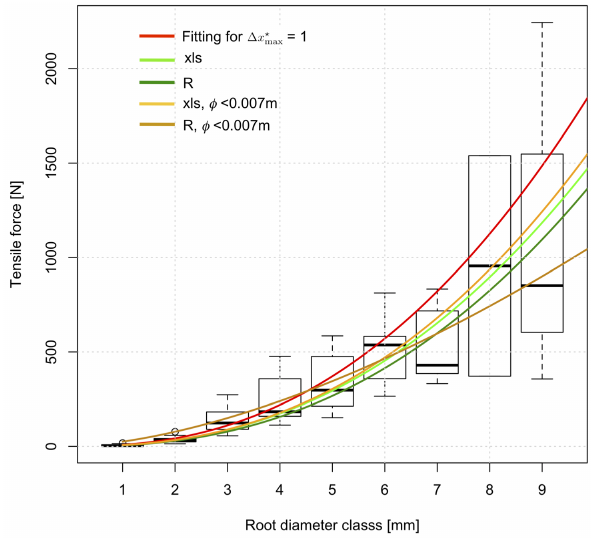
Fig. A1. Boxplot of the maximal tensile force measurement in func- tion of root diameter classes. The three different fitting curves cor- respond to the fit of all data (light green=xls, dark green=R), the fit of data up to 0.007m diameter (light orange=xls, dark orange=R), and finally the iteratively fitted curve to obtain a normalized fail- ure displacement equal to 1 (red). (n1=23, n2=17, n3=7, n4=12, n5=14, n6=11, n7=6, n8=2,